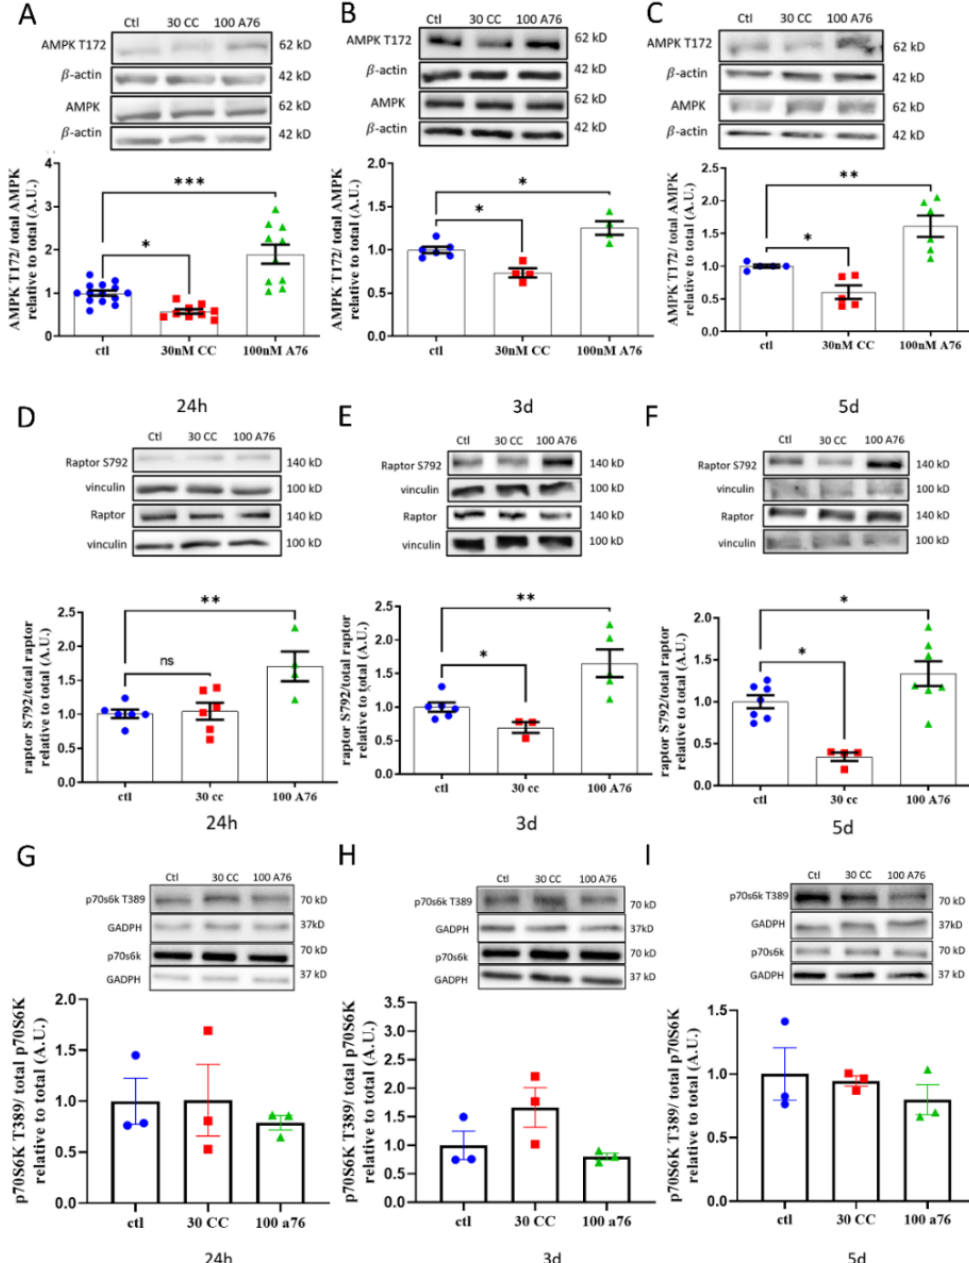
Figure 2. Chronic effects of Compound C (CC; Red) and A-769662 (A76; Green) on AMPK, raptor, and p70S6K. Western blot analysis for phosphorylated AMPK T172 ( A – C ), Raptor S792 ( D – F ), and p-p70S6K T389 ( G – I ) in SH-SY5Y neuroblastoma cells following 24 h, 3 d, and 5 d treatments of AMPK activator A-769662 (100 nM) and inhibitor Compound C (30 nM). Control is shown as Blue circles. Representative Western blots provided above figures. Results represent independent experiments (N = 3–8). Data are presented as mean ± SEM. * Indicates significant ( p < 0.05) difference from ctl, ** Indicates significant ( p < 0.005) difference from ctl, *** Indicates significant ( p < 0.0005) difference from ctl as determined using a one-way ANOVA followed by Tukey’s post hoc analysis.